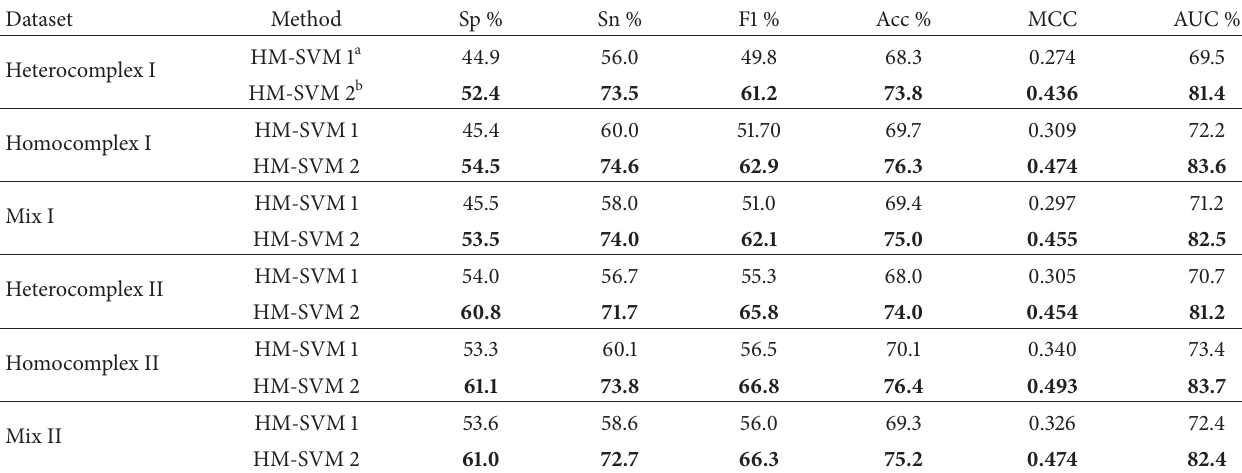
Table 2: Performance of HM-SVM based method with and without order profile propensities.